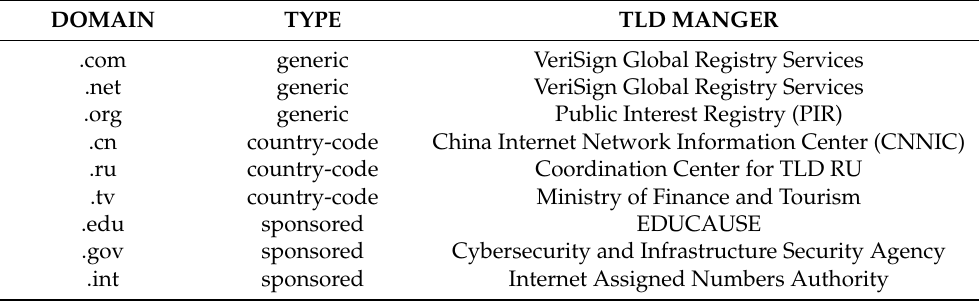
Algorithm 1 Generating BadTLD Backdoor